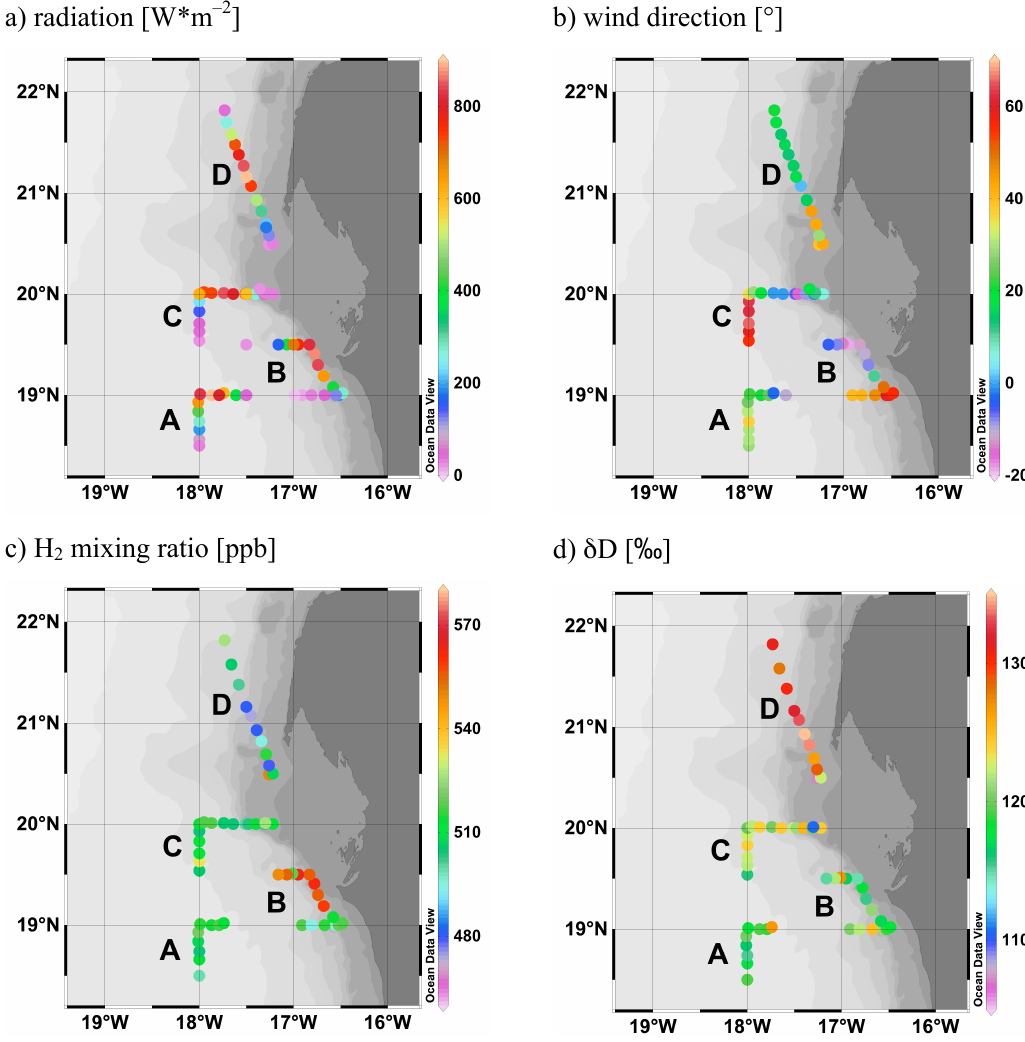
Fig. 5. Sampling positions with color-coded results for (a) radiation (Wm − 2 ), (b) wind direction ( ◦ ), (c) H 2 mixing ratio (ppb), and (d) δ D (‰). The labels in each subfigure A to D indicate the days of high-resolution sampling: A: 20 February 2007, B: 21 February 2007, C: 22 February 2007, and D: 23 February 2007. Note: the wind direction is given in a range from − 180 ◦ to 180 ◦ to give a better resolution (0 ◦ means wind coming from northern directions; Schlitzer,